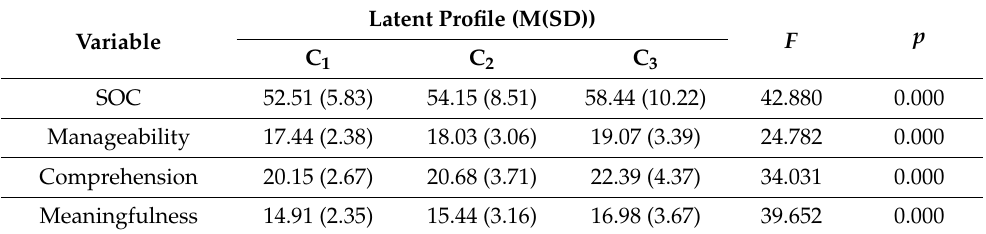
Table 8. Class comparisons on the sense of